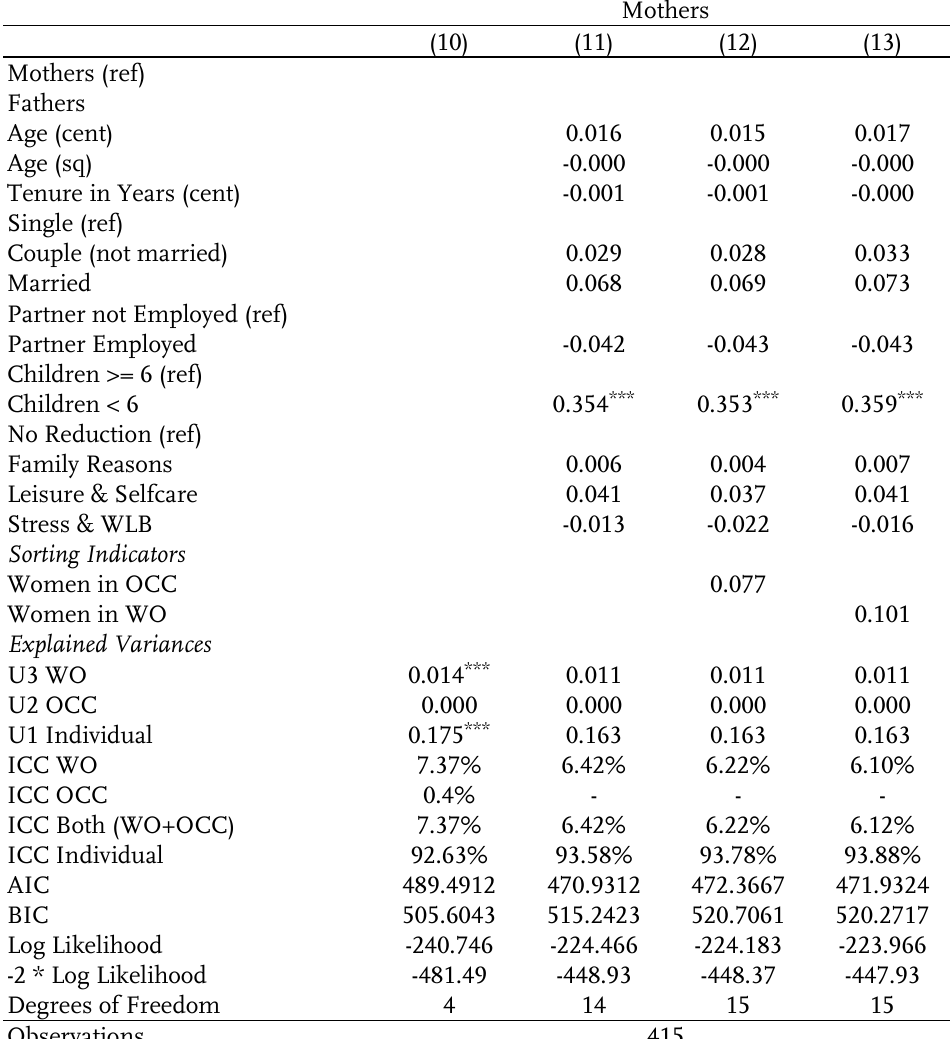
Table 3 : Cross-classified multilevel model on reduction of contracted work